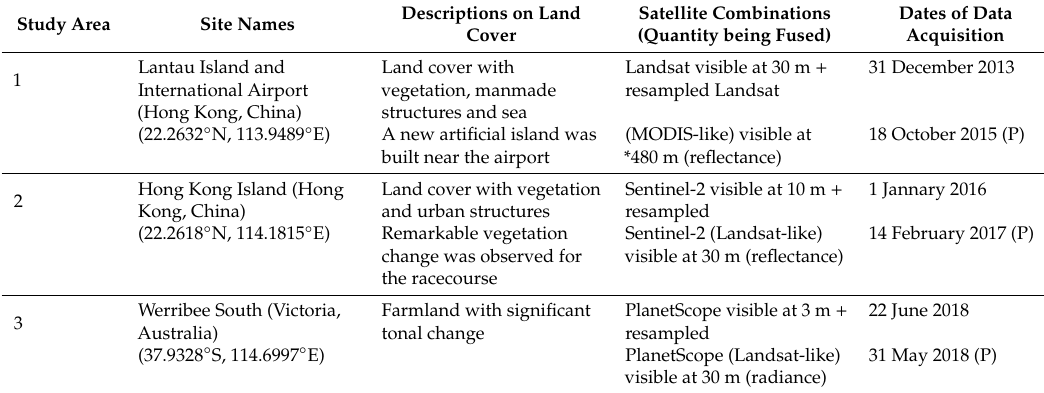
Table 1. Details of study areas for simulated